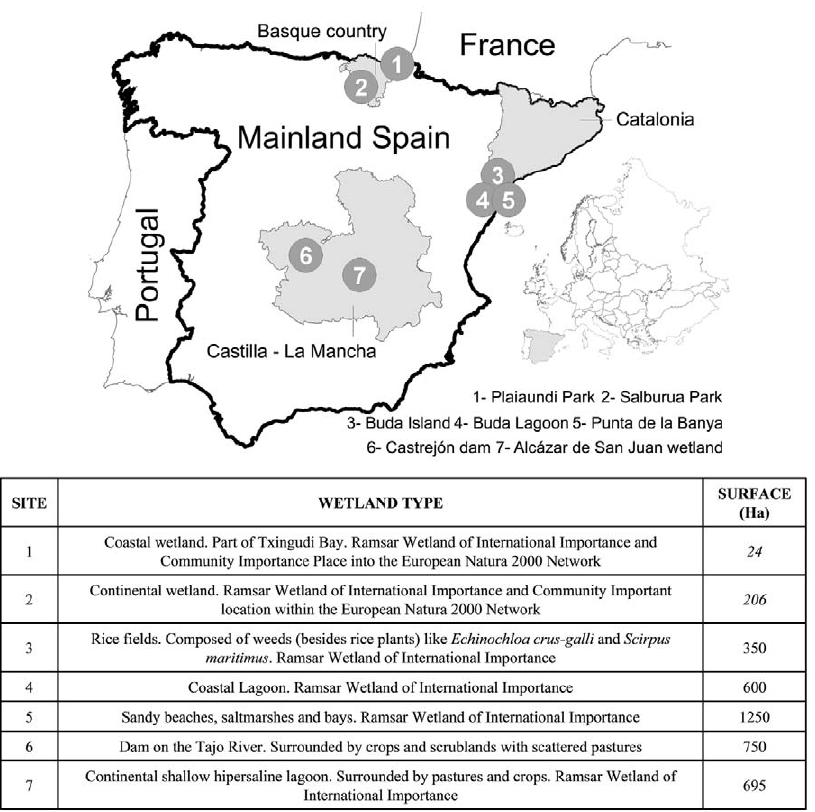
Figure 1. AIV ecology in Spanish wetlands: study area and sampling locations.